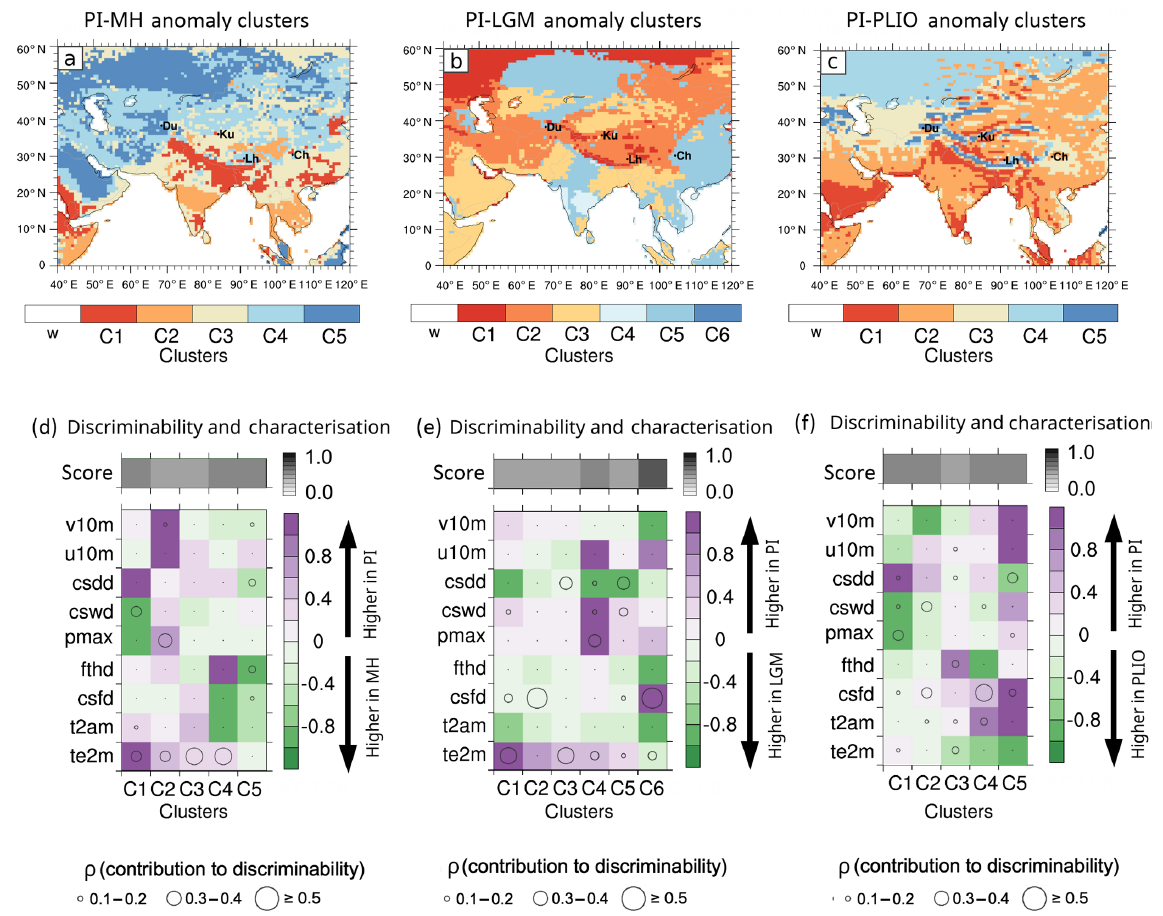
Figure 5. The multivariate anomaly maps for time slice comparisons PI–MH (a) , PI–LGM (b) and PI–PLIO (c) show the geographical coverage of clusters C 1 – C i in the South Asia, which describe the spatial extent of regions characterised by similar modes of change. The corresponding modes of change (d, e, f) for each cluster are expressed as relative changes in each of the nine investigated variables (Table 1): 2m air temperature (te2m), 2m air temperature amplitude (t2am), consecutive freezing days (csfd), freeze–thaw days (fthd), maximum precipitation (pmax), consecutive wet days (cswd), consecutive dry days (csdd), zonal near-surface wind speeds ( u 10) and meridional near- surface wind speeds ( v 10). The score (d, e, f) expresses the goodness of discriminability between palaeoclimate pairs PI–MH (d) , PI–LGM (e) and PI–PLIO (f) in each of the anomaly clusters. The size of the circles corresponds to the relative contribution of each of the nine climatic attribute variables to the measured discriminability in each anomaly cluster for all three time slice